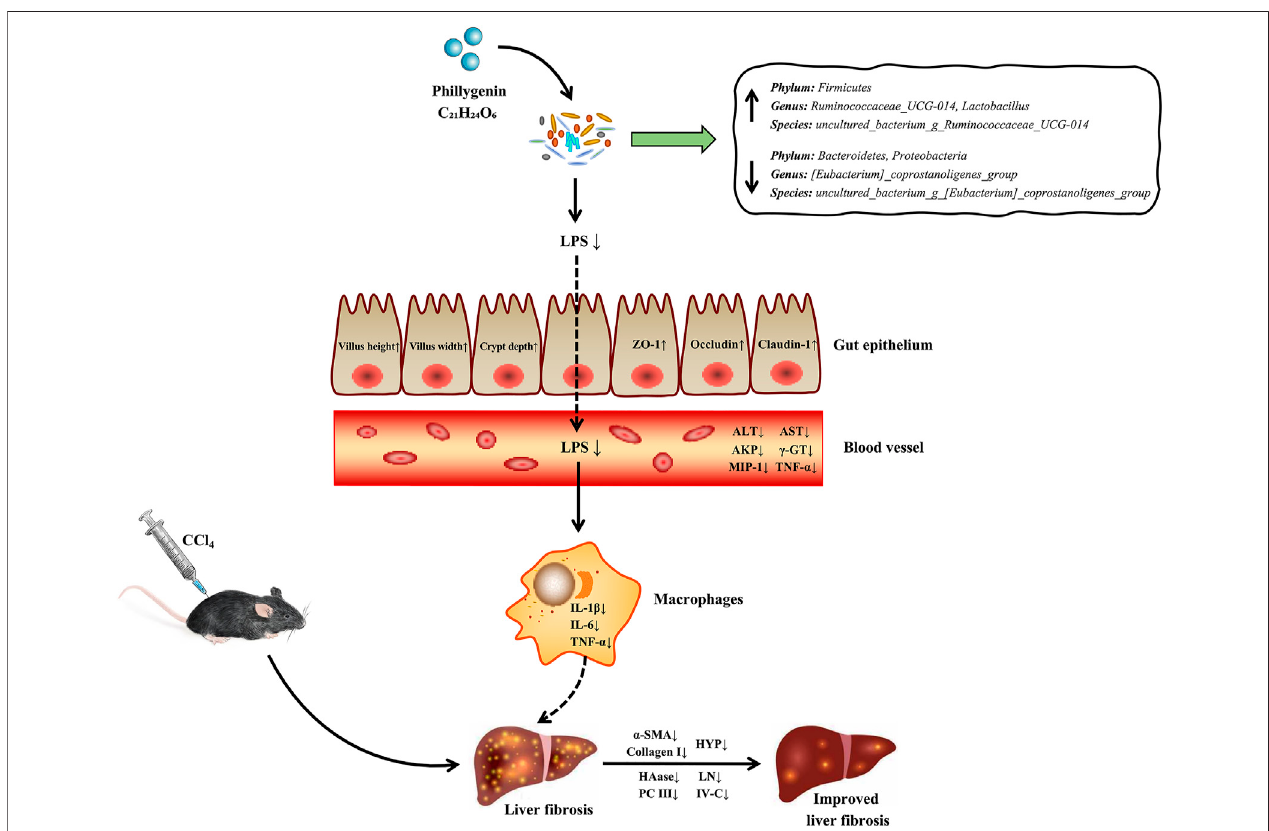
FIGURE 11 | The potential mechanism of PHI in alleviating CCl 4 -induced liver fi